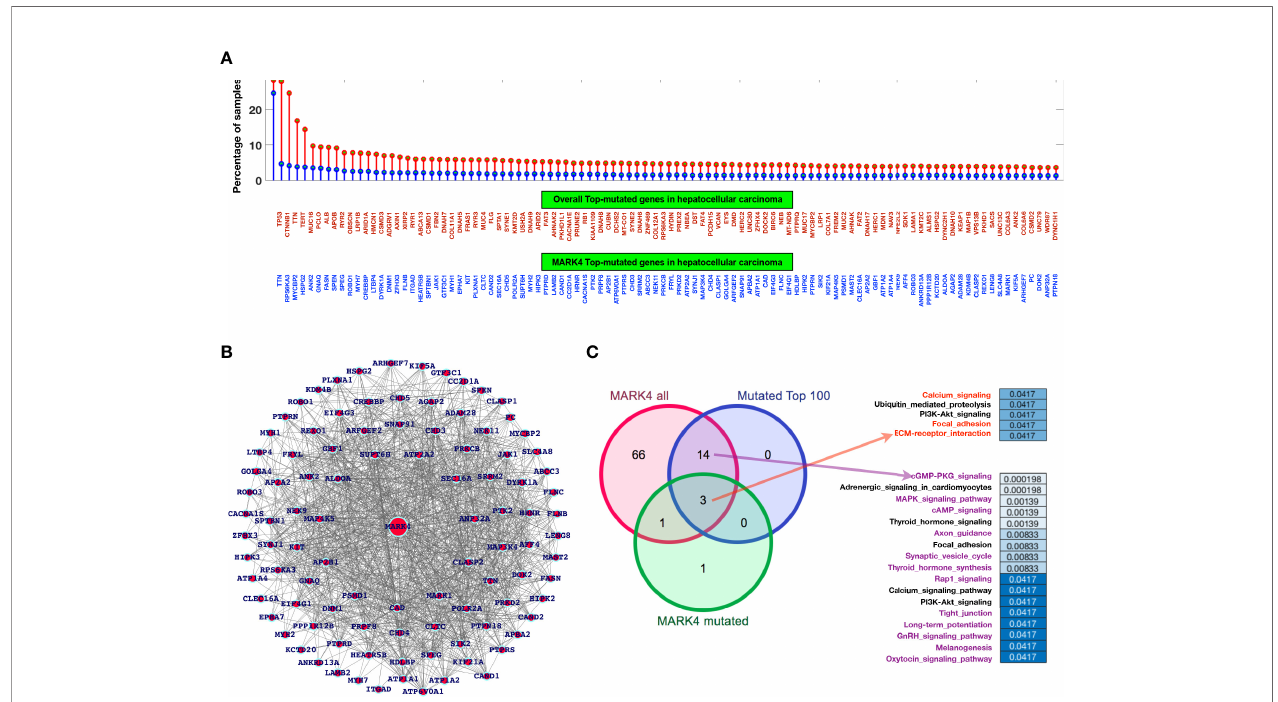
FIGURE 5 | Mutational pro fi ling and pathway-level understanding. (A) Top-ranked genes based on a mutation in the selected dataset for overall genes in the case of HCC and the genes common to MARK4-interactors. (B) Network representing top-ranked mutated genes associated with MARK4. (C) Venn diagram to map out the common and exclusively enriched